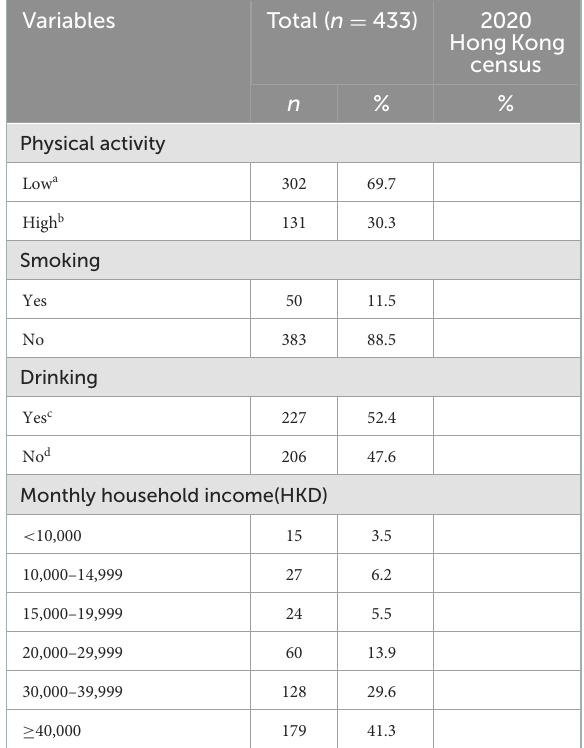
TABLE 3 Characteristics of survey